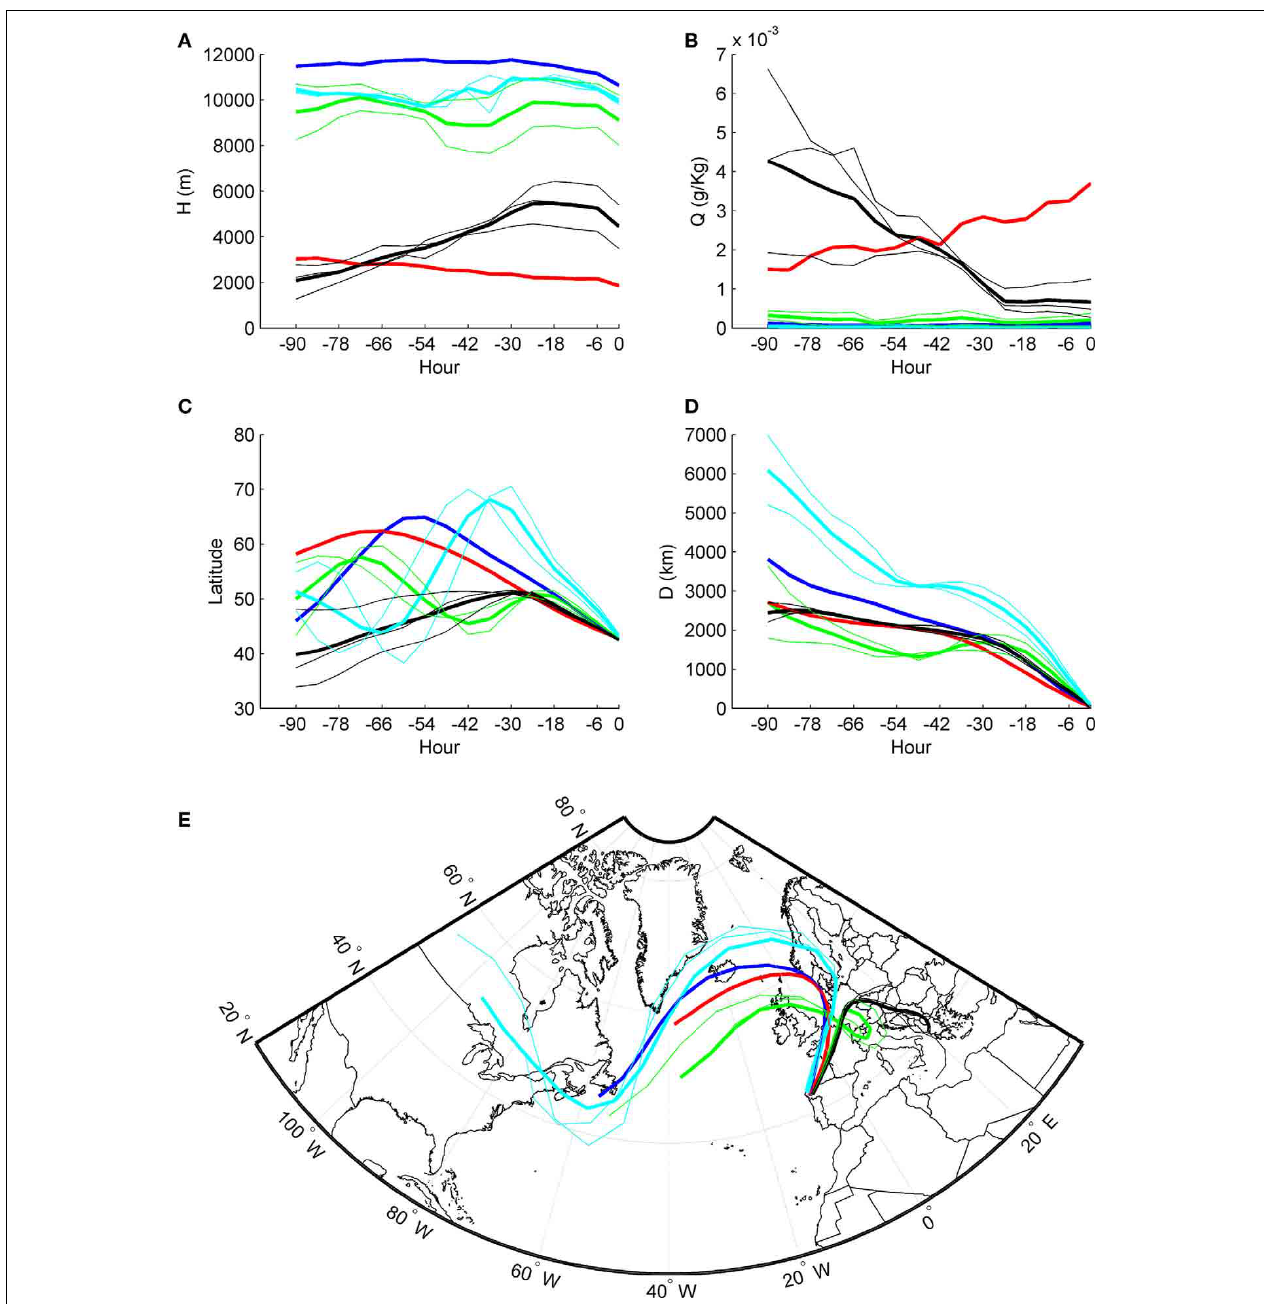
FIGURE 3 | Time evolution of the back-trajectory properties for (A) height of trajectory (H), (B) specific humidity (Q), (C) latitude and (D) distance to the center (D) shown in Figure 1. The colored thin line corresponds to the centroid trajectories (previous computed with